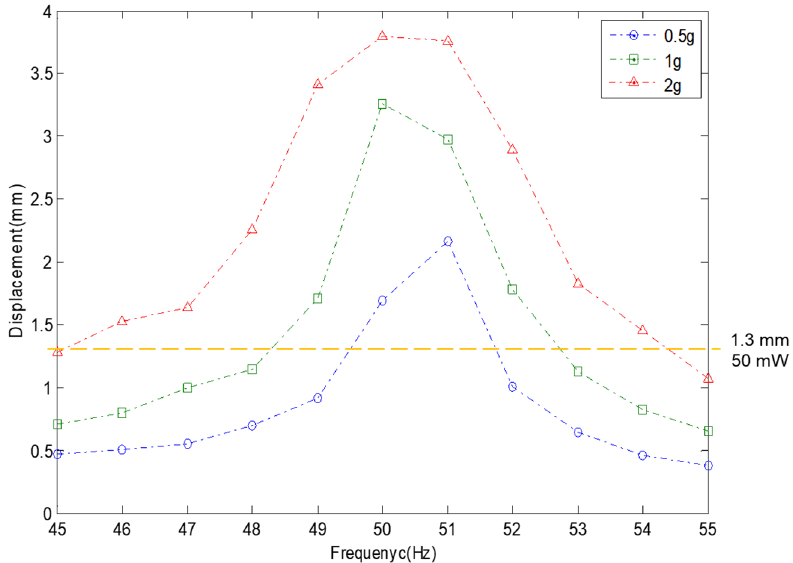
Figure 12. The test results of the moving displacement for the spring according to the vibration acceleration at one lower coil of the VEH device. The VEH device with a resonant frequency of 50 Hz was tested to increase the frequency by 1 Hz in the 50 Hz ± 5 Hz frequency band under 0.5, 1.0 and 2.0 G vibration acceleration conditions. The thickness of the spring was 1.0 mm. The maximum moving displacement of spring was 4.0 mm.